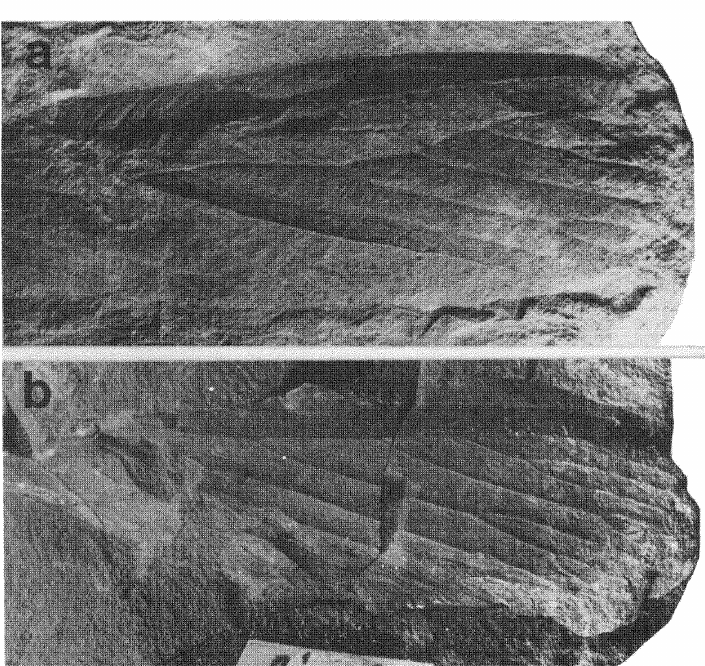
Fig. 21.Genentomum validum, photographs of holotype no. USNM 38135. a. fore wing. Length 42 mm, as preserved, b. hind wing. Length 40 ram, as